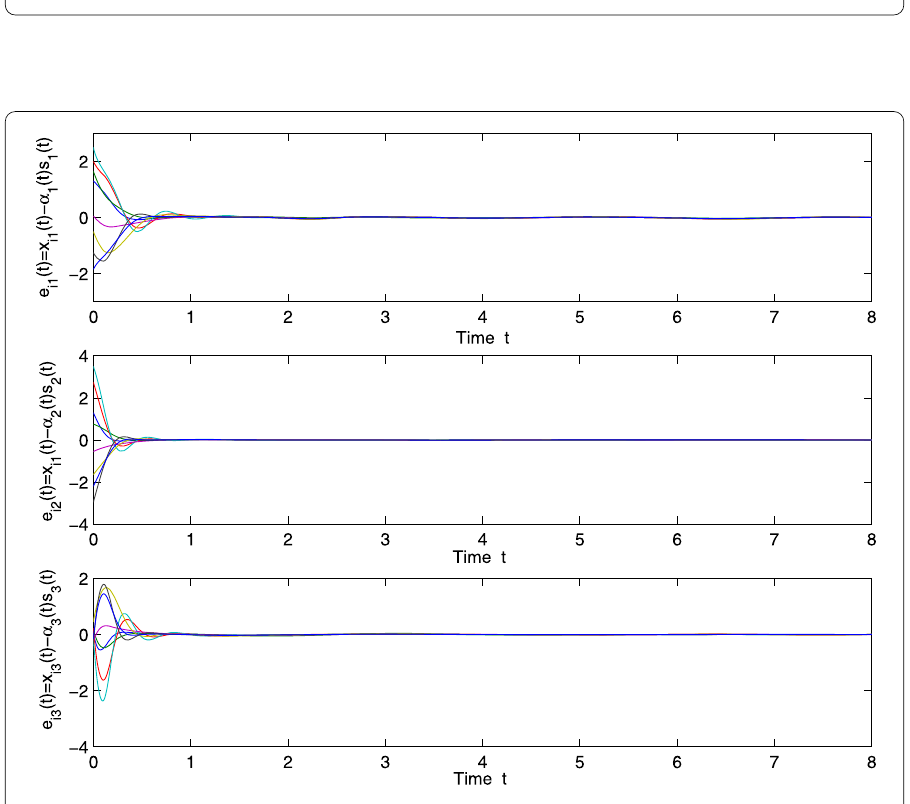
Figure 3 The modified function projective synchronization errors between the states of isolate node α ( t ) s ( t ) (38) and node x i ( t ) (39), i = 1,2,...,8, without hybrid adaptive control (5).